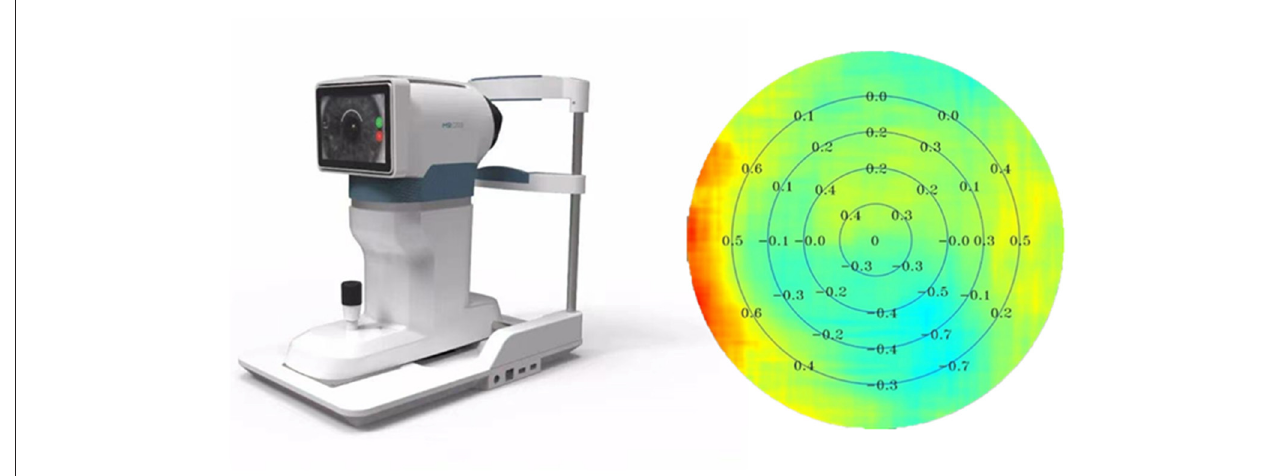
FIGURE 2 | Multispectral refraction topography and the report.